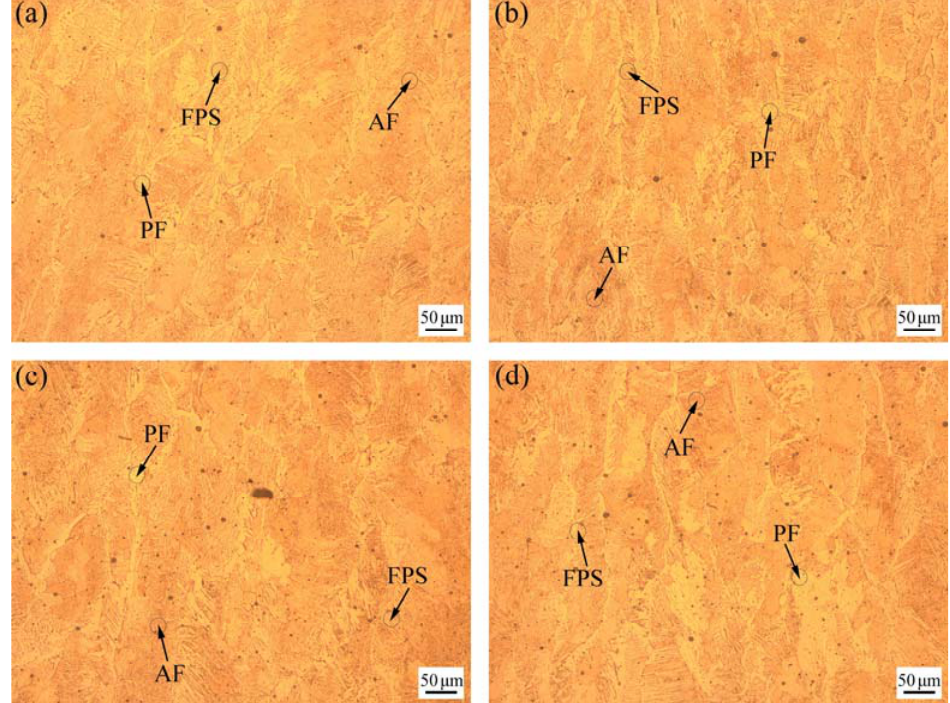
Figure 14. Microstructure of the weld metal under different pulse frequencies at an ultrasonic exci ‐ tation voltage of 40 V: ( a ) 20 kHz; ( b ) 40 kHz; ( c ) 50 kHz; ( d ) 60 kHz. excitation voltage of 40 V: ( a ) 20 kHz; ( b ) 40 kHz; ( c ) 50 kHz; ( d ) 60